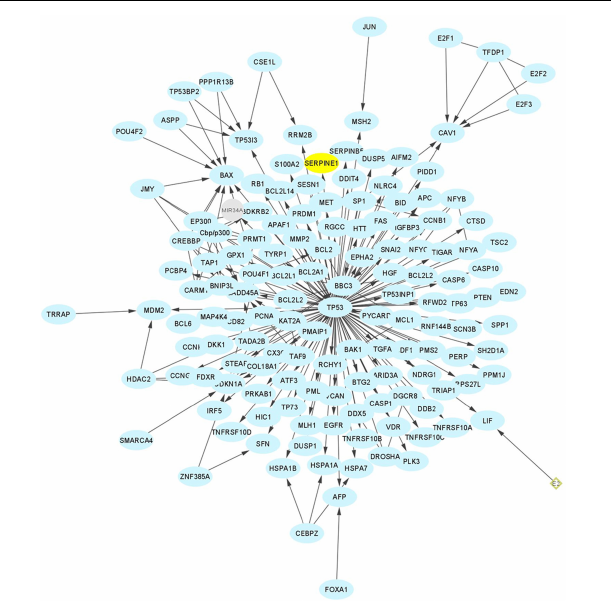
FIGURE 11 | Direct p53 effectors. There are a significant number of p53 target genes that control a broad range of cellular processes, including cell cycle arrest, cell senescence, DNA repair, metabolic adaptation and cell death. Of these, approximately 135 are listed in the Pathway Interaction Database as direct p53 effectors. SERPINE1 (PAI-1) (highlighted in yellow) is among the most prominent since, as a major p53 target gene, it regulates cell proliferation and migration, ECM remodeling, wound healing, invasion and metastasis, senescence and survival (e.g., Higgins et al., 2018, 2019; Tang et al.,